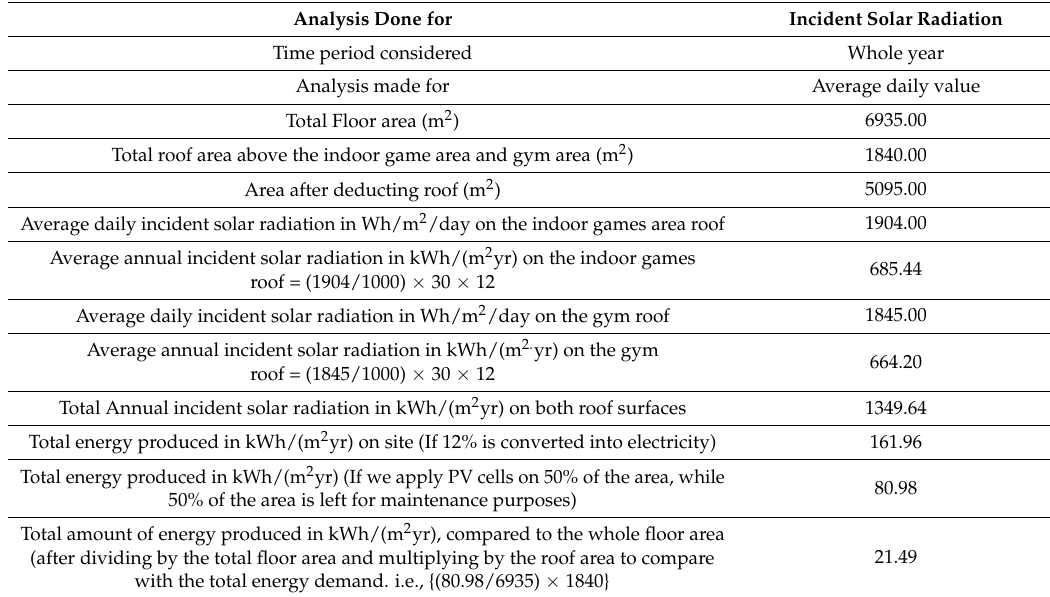
Table 9. Onsite energy production through solar access